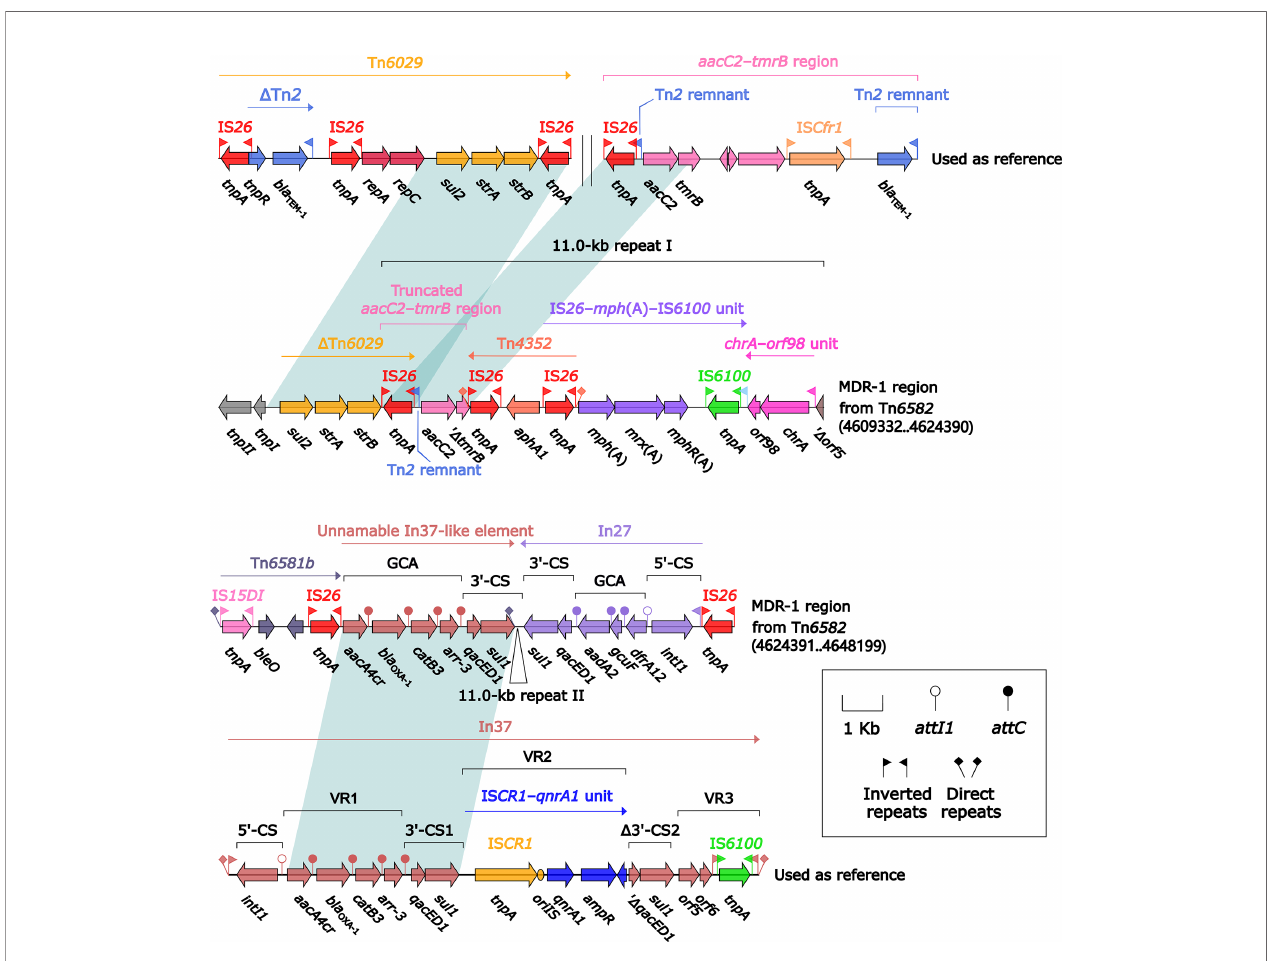
FIGURE 5 | Organization of MDR-1 region from Tn 6582 , and comparison to related regions. Genes are denoted by arrows. Genes, mobile elements, and other features are colored based on their functional classi fi cation. Shading denotes regions of homology (nucleotide identity ≥ 95%). Numbers in brackets indicate nucleotide positions within the chromosome of strain QD23. The accession numbers of Tn 6029 (Cain et al., 2010), aacC2 – tmrB region (Partridge et al., 2012), and In37 (Wang et al., 2003) used as reference are GQ150541, JX101693, and AY259086, respectively.